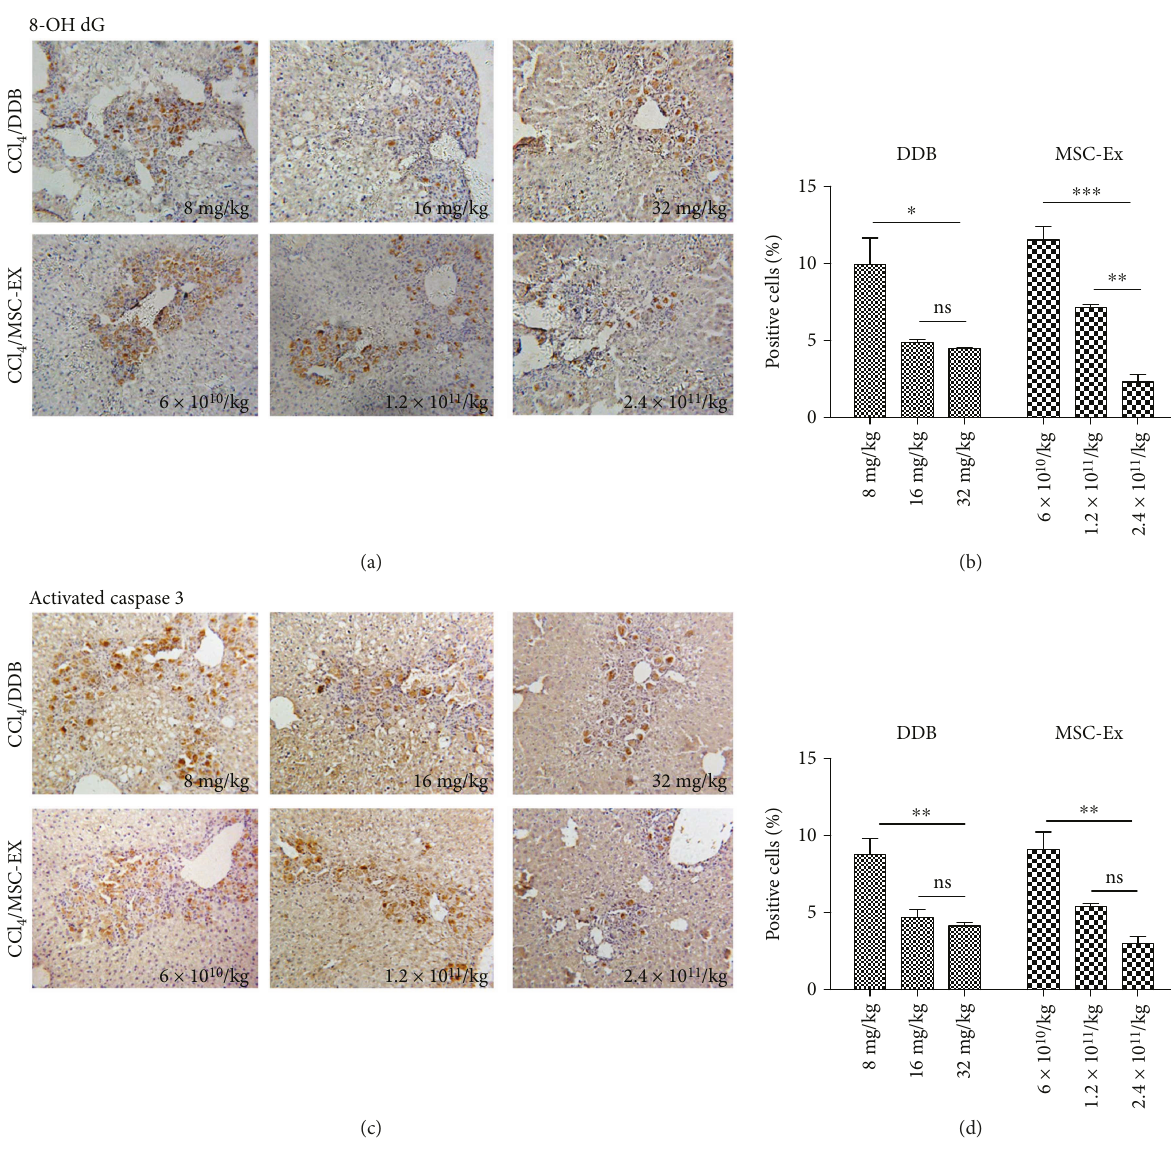
Figure 5: hucMSC-Ex exerted a more e ff ective antioxidant than DDB in CCl -induced liver injury. (a, b) Immunohistochemistry staining of 4 8-OHdG in mouse livers after treatment with DDB (8 mg/kg, 16 mg/kg, and 32 mg/kg) or hucMSC-Ex (6 × 10 10 particles/kg, 1.2 × 10 11 particles/kg, and 2.4 × 10 11 particles/kg) ( n = 10 ; ∗ P < 0 05 , ∗∗ P < 0 01 , and ∗∗∗ P < 0 001 ). (c, d) Immunohistochemistry staining of activated caspase 3 in mouse livers after treatment with DDB (8 mg/kg, 16mg/kg, and 32 mg/kg) or hucMSC-Ex (6 × 10 10 particles/kg, 1.2 × 10 11 particles/kg, and 2.4 × 10 11 particles/kg) ( n = 10 ; ∗∗ P < 0 01 ). Compared with the PBS group, hucMSC-Ex (2.4 × 10 11